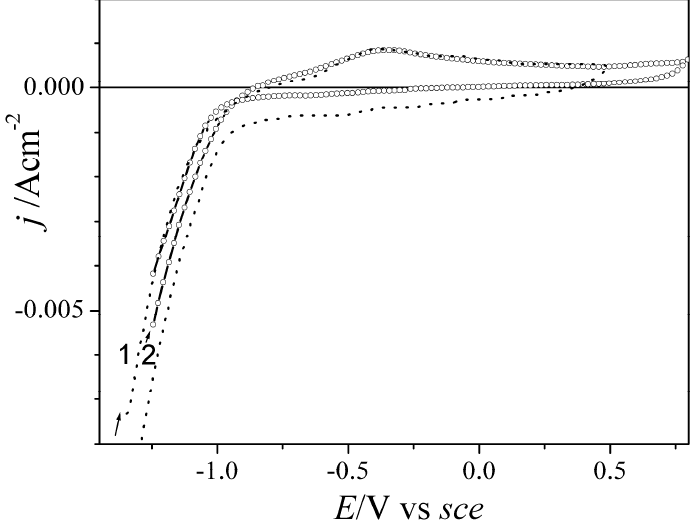
Fig. 4 Cathodic-anodic potentiodynamic curves of the Fe 1 – sample A, 2 – sample B. Scan rate 0.1 Vs − 1